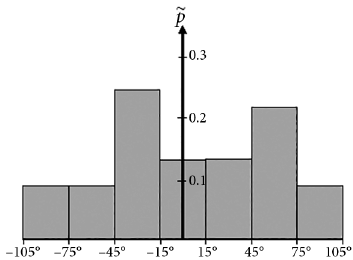
Figure 3. Histogram of the selective distribution of the deviation of the directions of the error vectors relative to the direction to the base station